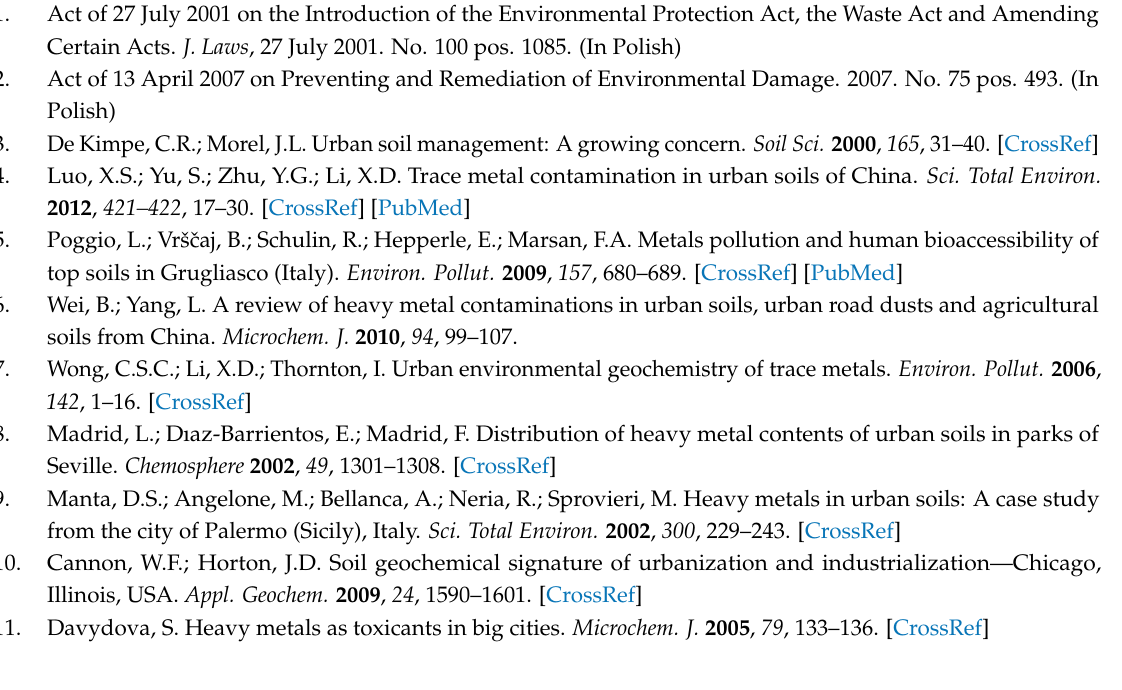
Table S1. Concentration of the tested elements (mg/kg d.m.) in the soil depending on the depth of sampling, Table S2. Statistical significance of the tested elements in the soil depending on the site of sampling, Table S3. Statistical significance of the tested elements in the soil depending on the depth of